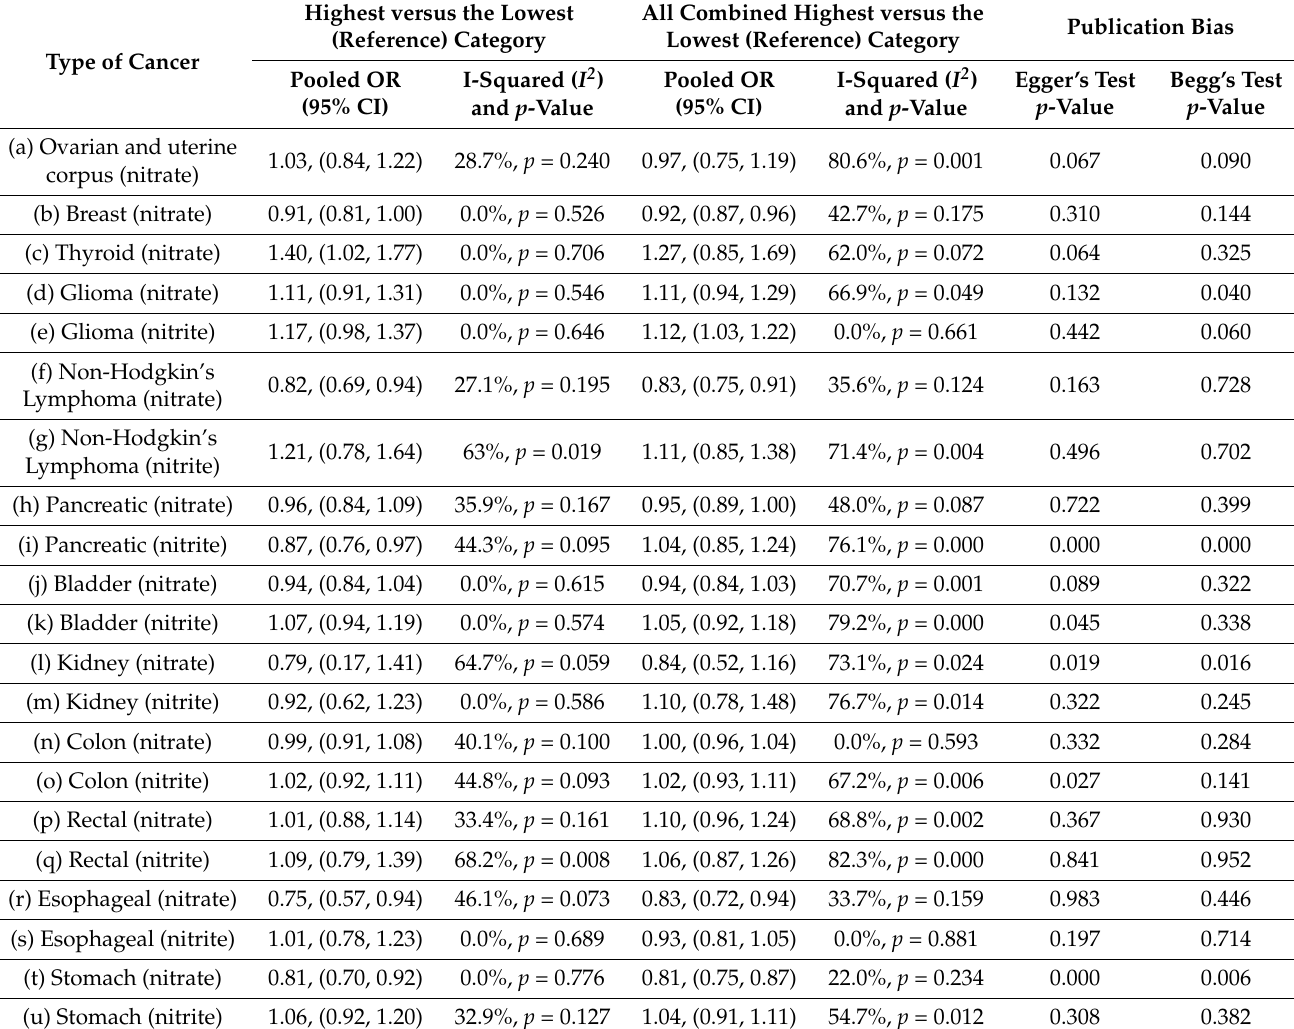
Table 1. Meta-analysis of pooled ORs (95% CI) of the highest versus lowest category and all com- bined higher versus the lowest category of dietary nitrate and nitrite consumption for selected, site-specific